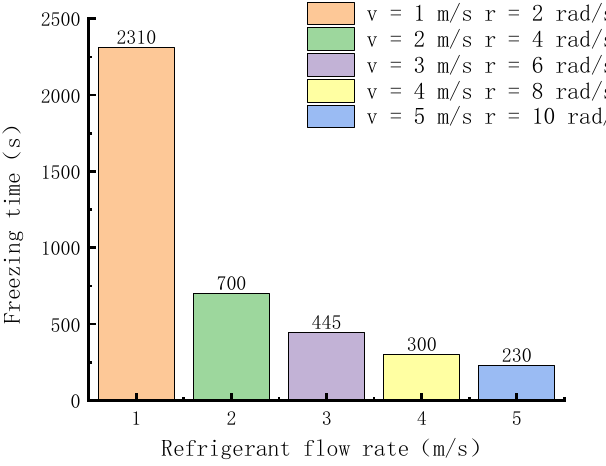
Figure 15. Histogram of refrigerant flow rate, carrier frame speed and freezing time.